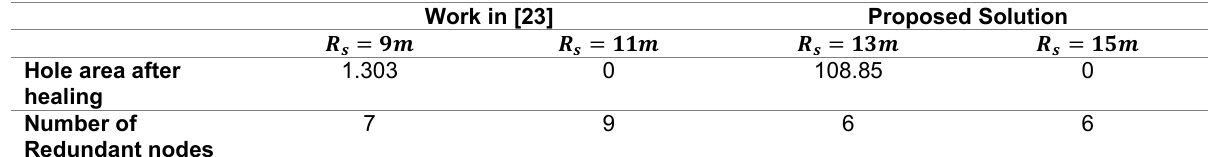
Table 4. Comparison of proposed solution with